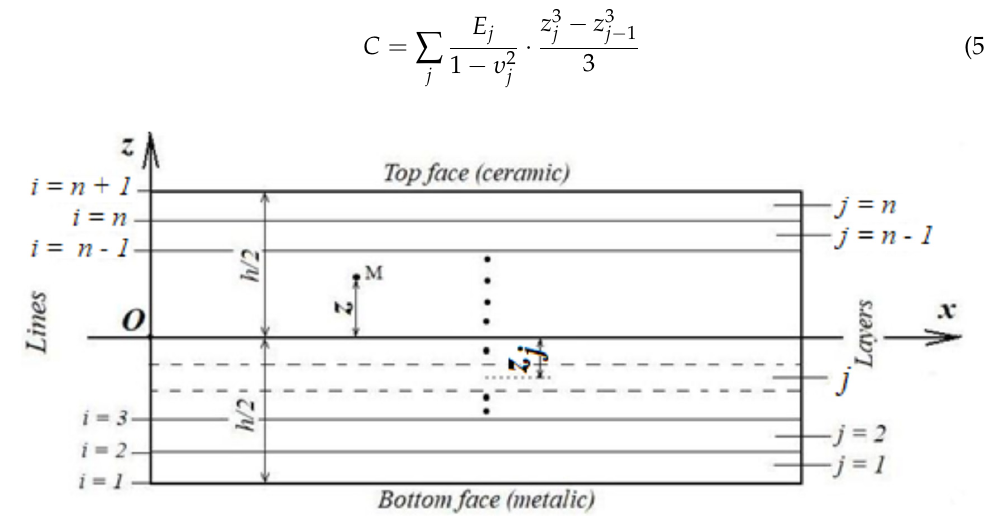
Figure 4. The reference system, the lines “ i ” and layers “ j ” that define the multilayer plate.